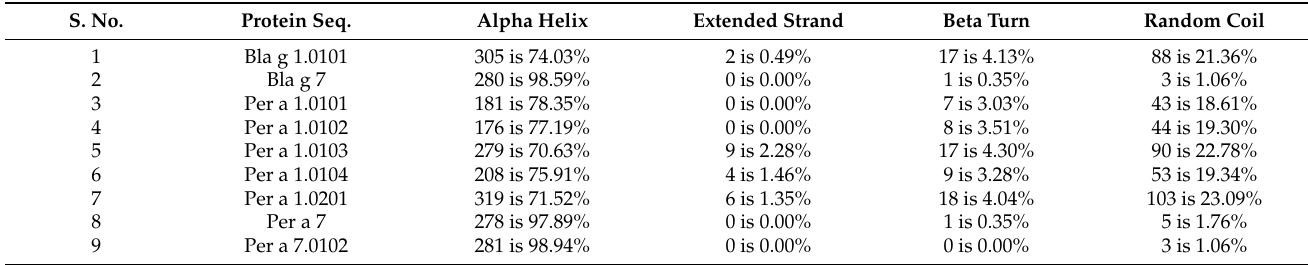
Table 5. Secondary structure analysis of nine screened protein